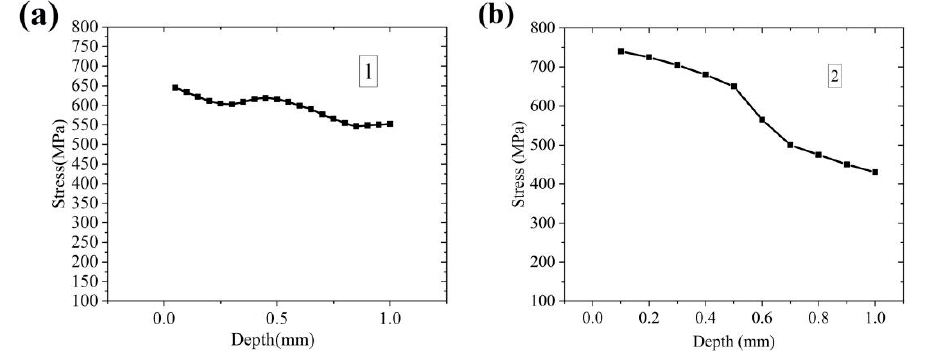
Figure 11. Test results of gradient residual stress: ( a ) central position; ( b ) edge position.